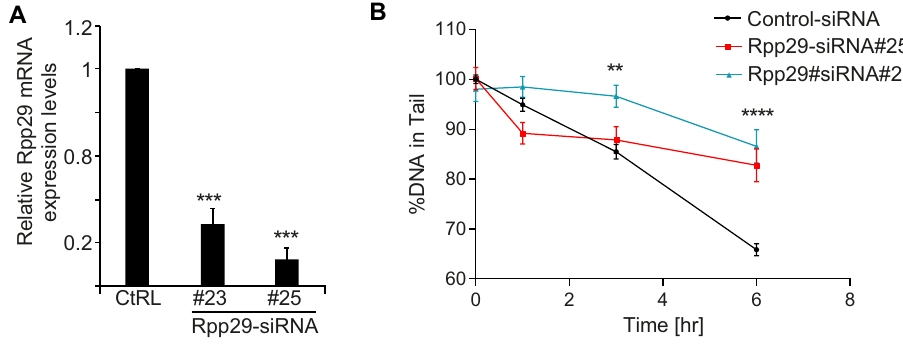
Figure 1. Rpp29 promotes repair of IR-induced DNA damage. ( A ) Real-time PCR analysis shows ~90% reduction in the steady state levels of Rpp29 mRNA in cells transfected with two different Rpp29 siRNAs, #23 and #25, and compared with those in cells transfected with control (CtRL) siRNA. P-values were calculated by two-sided Student’s t-test relative to ctrl siRNA; *** p < 0.001. ( B ) Control and Rpp29 depleted cells were exposed to 10 Gys of ionizing radiation (IR), harvested at the indicated time points after IR, and subjected to neutral comet assay. Quantitation of the DNA percentage in comet tail reveals DSB-repair deficiency in Rpp29 depleted cells. Error bars represent standard deviation (SD) from three independent experiments (n = 80 cells). Two-way ANOVA was used to test for differences at each dose; ** and **** indicate significance at p < 0.01 and p < 0.0001,